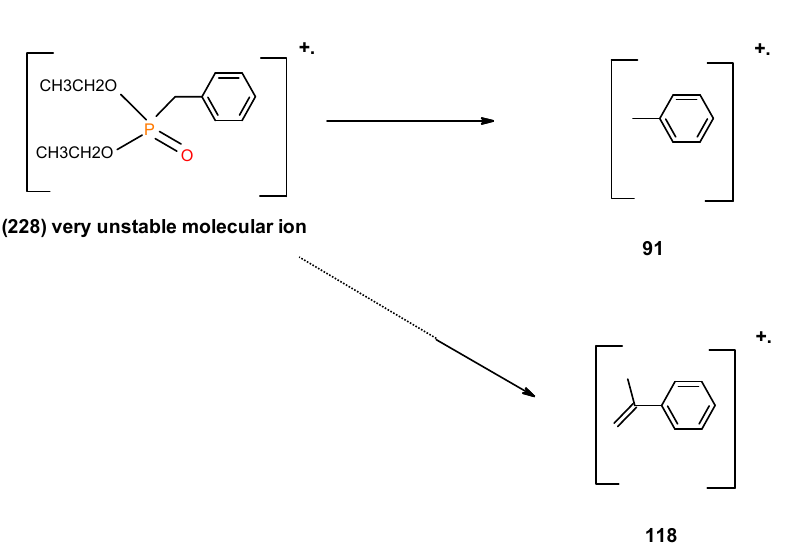
Figure 14. Possible fragmentation pattern of DEBP.